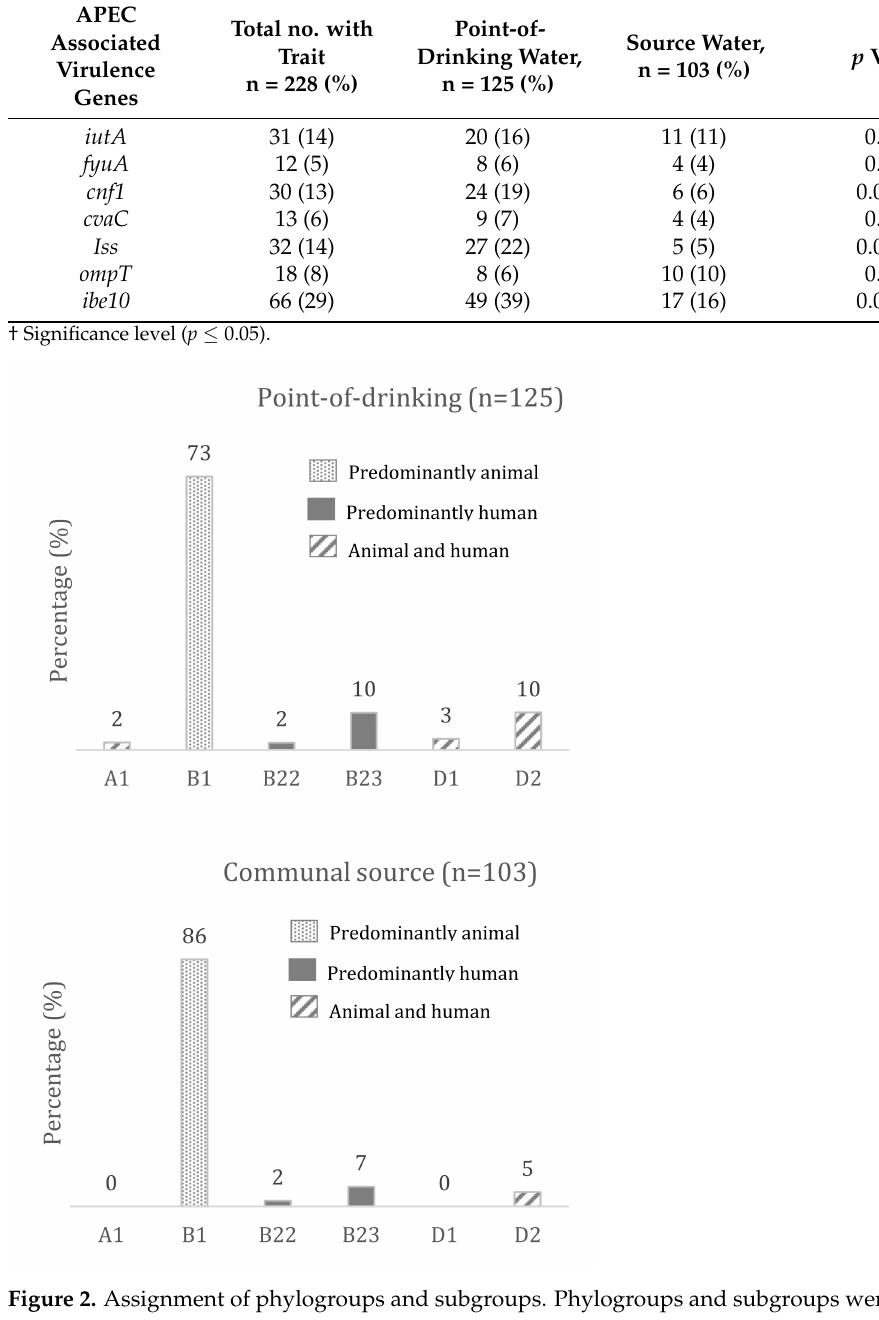
Figure 2. Assignment of phylogroups and subgroups. Phylogroups and subgroups were assigned among 228 isolates from the point-of-drinking water and the source water in Arichpur, Dhaka, collected from September 2014 to October